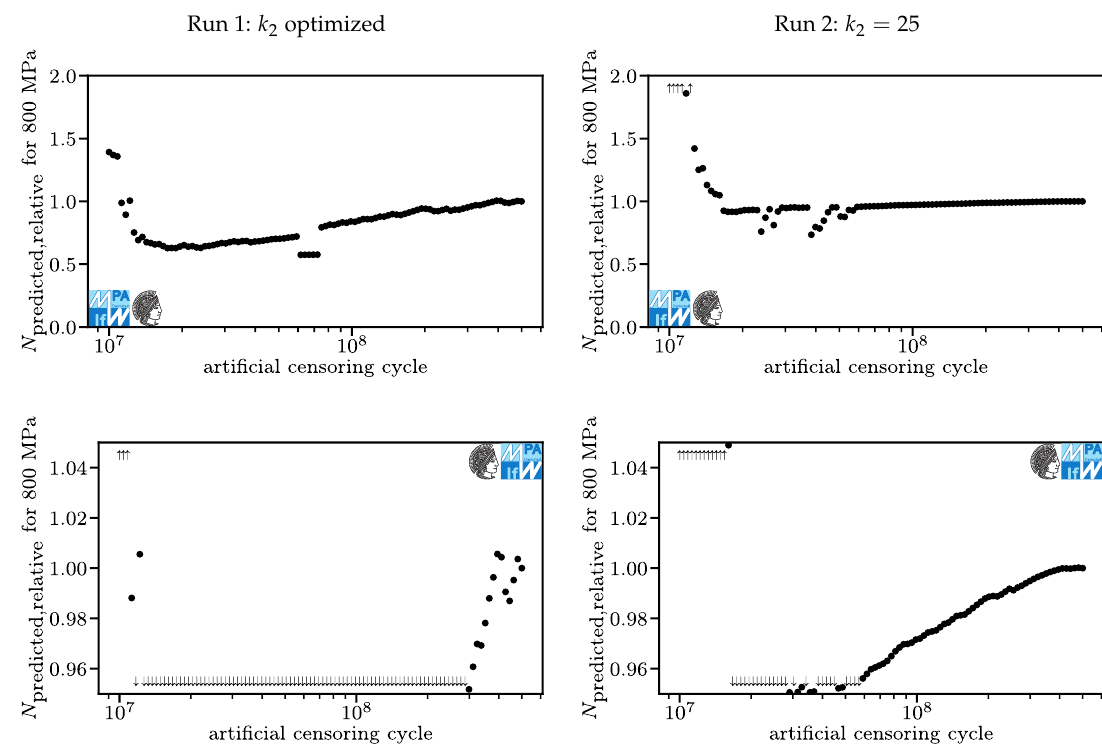
Figure 11. Lifetime predictions for Run 1 ( left ) and Run 2 ( right ), overview and detail for stroke stresses of 800